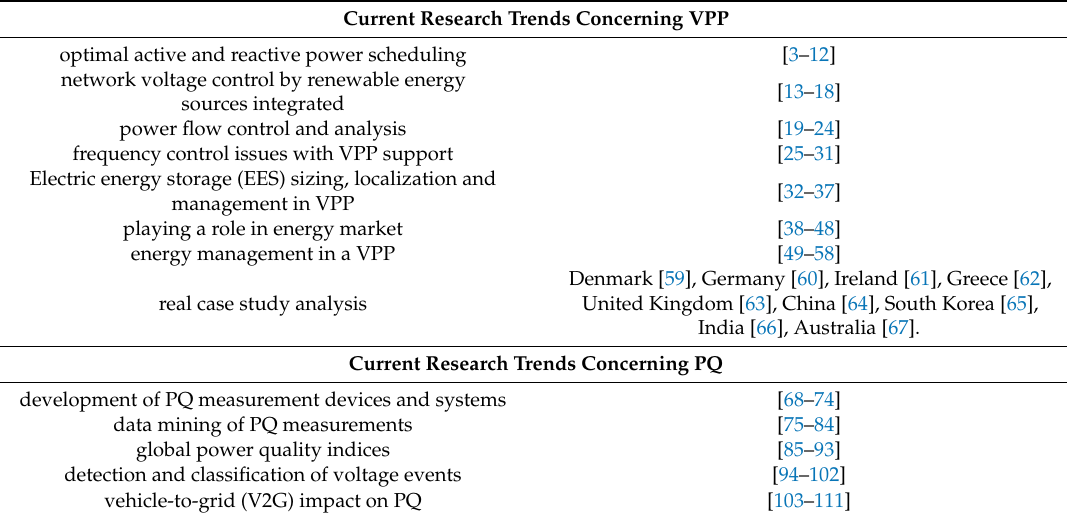
Table 1. Current research trends concern virtal power pland (VPP) and power quality